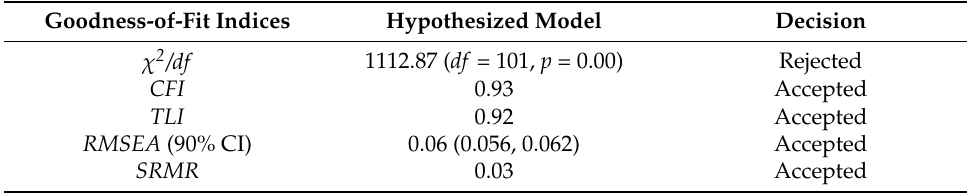
Table 2. Goodness-of-fit indices for the hypothesized model.